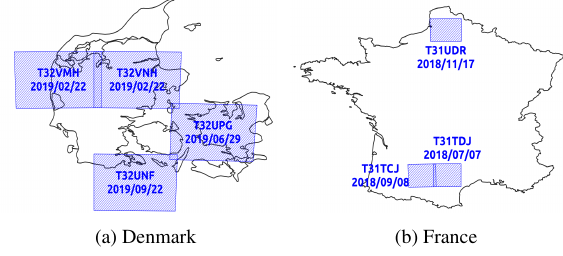
Figure 2. Selected satellite scenes over country borders Following the pre-processing described in section 3.1, we gen- erate for each country a dataset of images of shape 256 x 256 x 4 and their corresponding ground truth. The data were fi- nally split in training, test, and validation sets accounting for respectively 80%, 10% and 10% of the images. For such con- figuration, using an NVIDIA TITAN RTX GPU with 24GB of dedicated memory, the training over 10 epochs takes about 3.5 hours, while inference takes less than a few seconds per